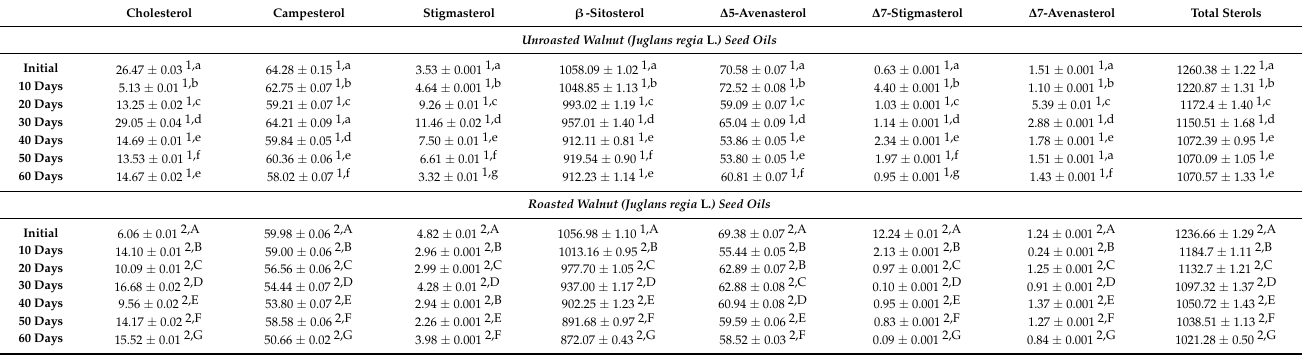
Table 3. The sterol composition (mg/kg) of UWO and RWO during 60 days of storage at 60 ± 2 ◦ C.